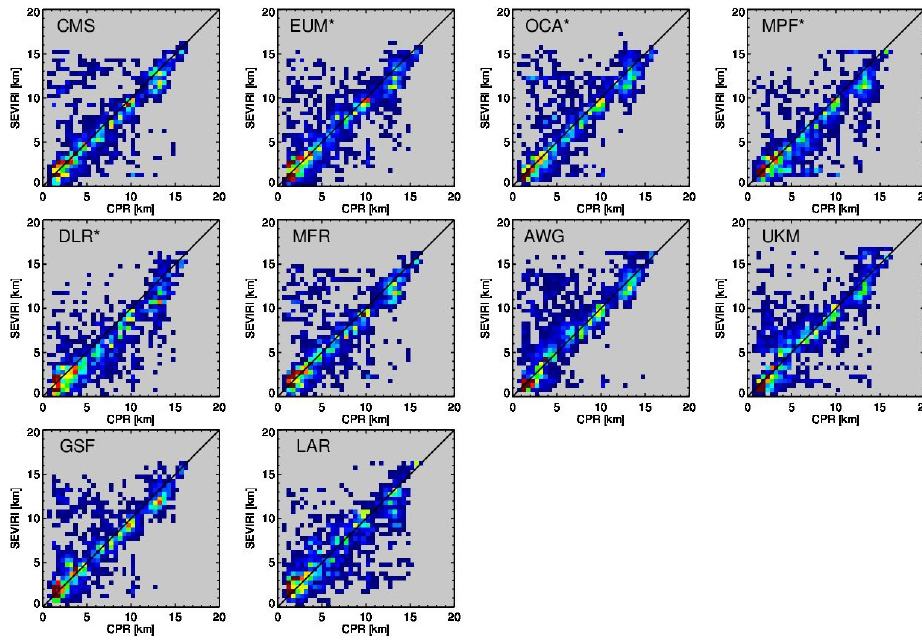
Figure 8. Same as Fig. 7, but for CPR. Pixels are taken into account, when all SEVIRI algorithms as well as the CPR retrieval provide CTH values. In comparison to CALIOP more data points are close to the one-to-one line.